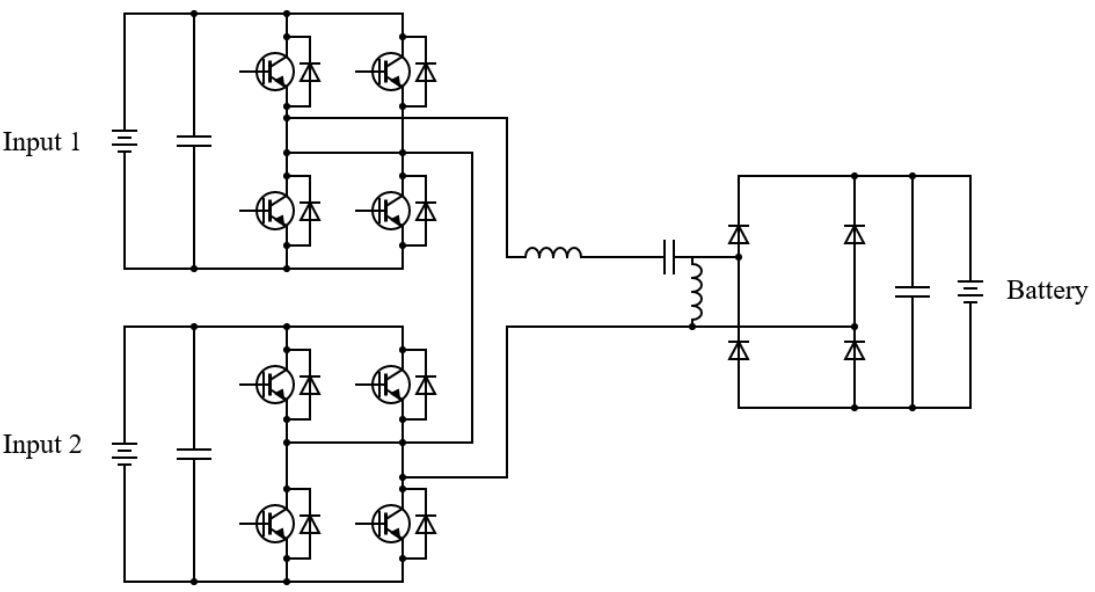
Figure 19. Five-level LLC converter [71].